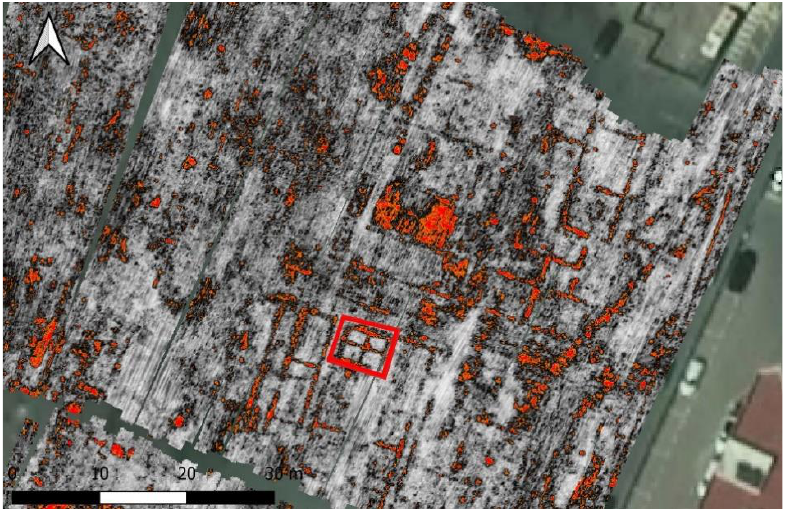
Figure 11. Detailed view of the northern part of the study area showing (red) the grid-shaped alignment of Set 4 at a depth of 0.6 m.